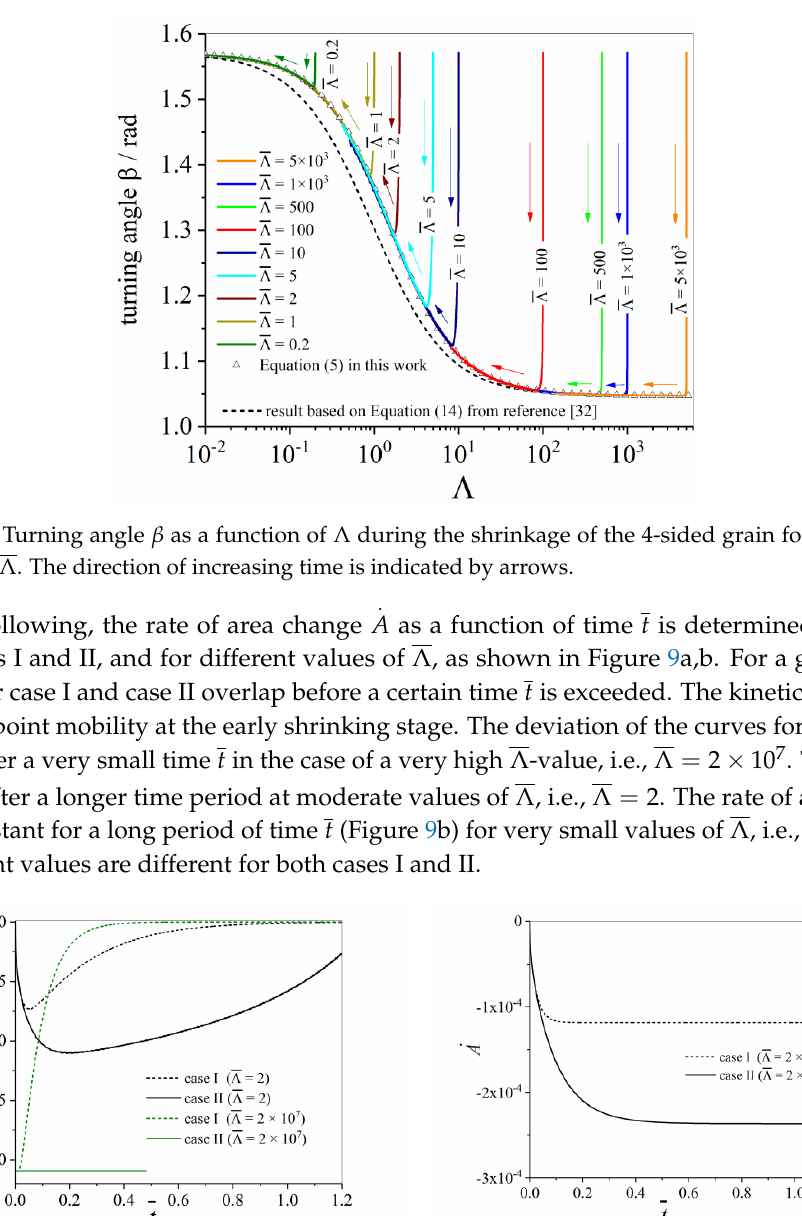
high value, Λ = 2 × 10 7 , and a medium value Λ = 2, ( b ) A very small value Λ = 2 × 10 − 4